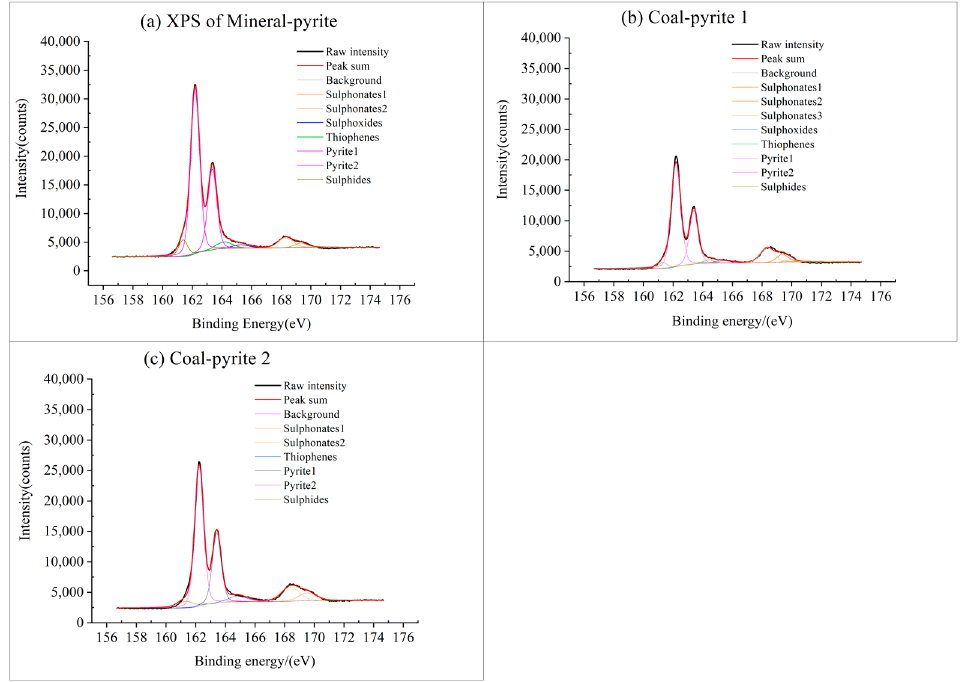
Figure 5. Sulfur types in pyrite samples based on XPS: ( a ) is the mineral-pyrite (M1); ( b ) is the coal-pyrite 1 (C1); ( c ) is the coal-pyrite 2 (C2). Table 3. Statistics of sulfur content and types based on XPS%.